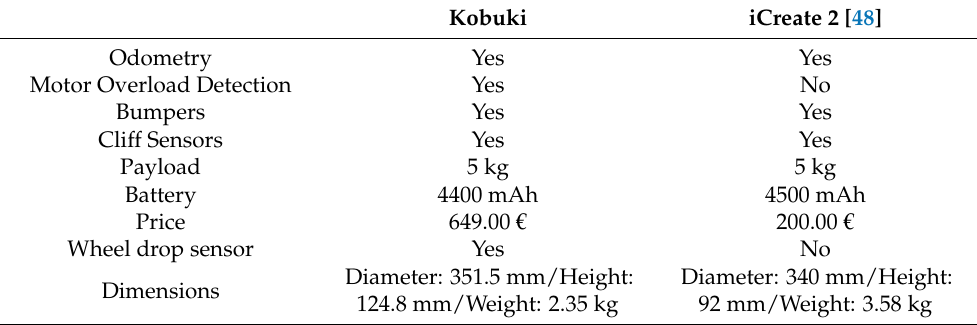
Figure 3. Kobuki Sensors. Table 1. Mobile Robot Base